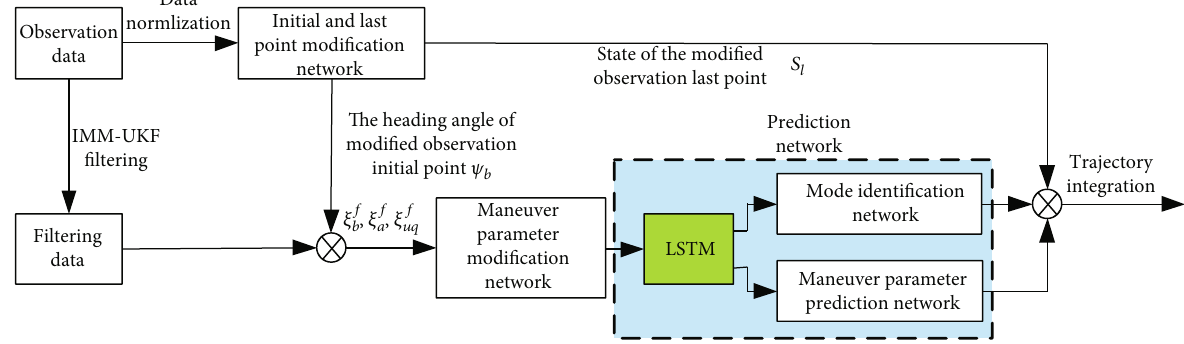
Figure 6: The prediction structure of the trajectory prediction based on the maneuver mode identi fi cation. Table 2: Maneuver modes design